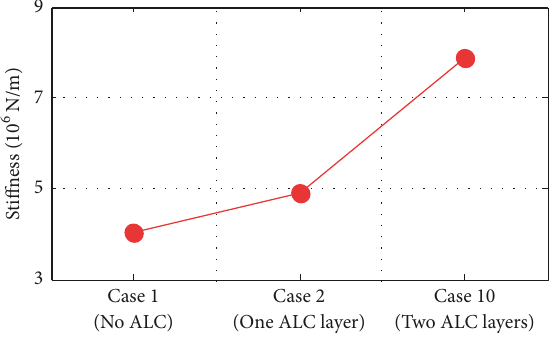
Figure 16: Effect of ALC external claddings on lateral stiffness.